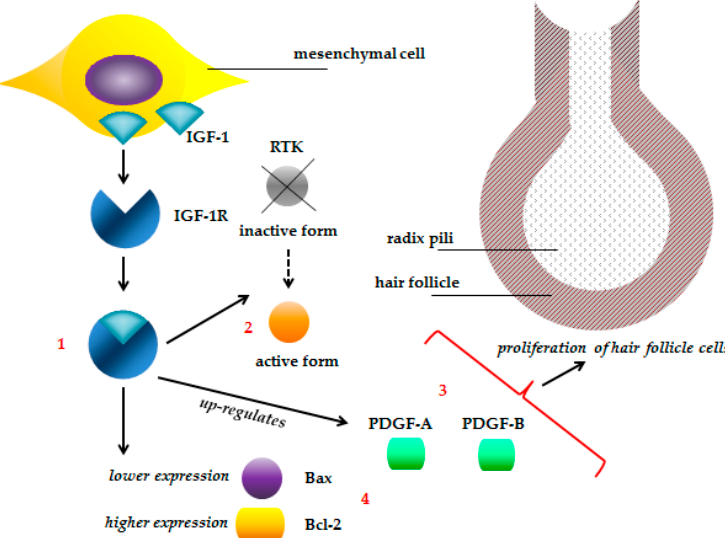
Figure 3. Role of IGF-1 in stimulation of hair follicle cell proliferation. Insulin like growth factor 1 (IGF-1) is produced by mesenchymal cells and binds to the insulin like growth factor 1 receptor (IGF-1R). This binding ( 1 ) activates the receptor tyrosine kinase (RTK) ( 2 ) [264], increases the expression of platelet-derived growth factors (PDGF-A, PDGF-B) ( 3 ) and the expression ratio of Bcl-2 (anti-apoptotic protein)/Bax (pro-apoptotic protein) ( 4 ), and thus stimulates the proliferation of hair follicle cells [262].